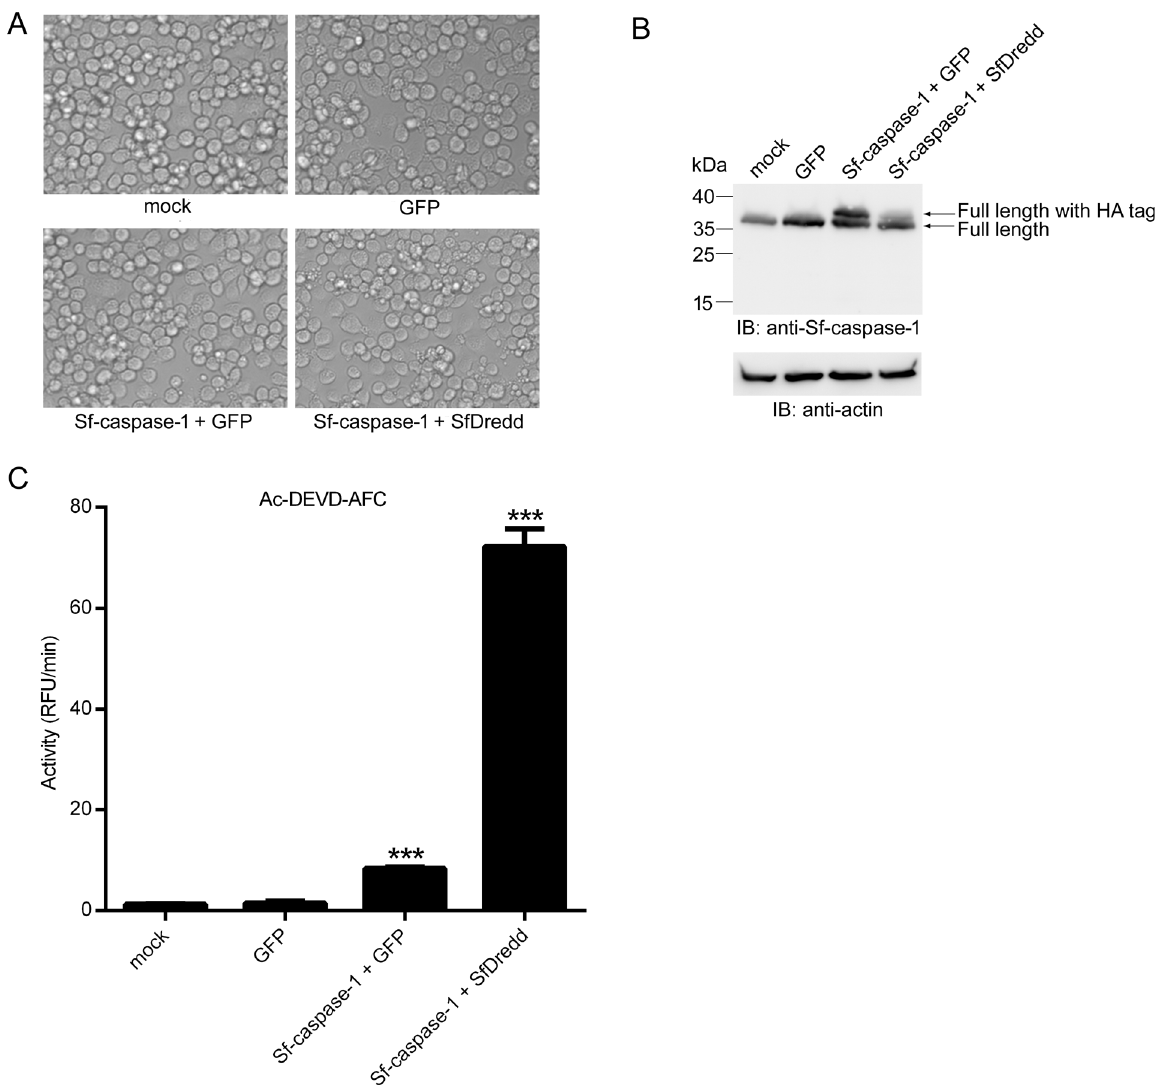
Fig 7. SfDredd cleaved Sf-caspase-1 when transfected in Sf9 cells. Plasmids expressing FLAG-tagged SfDredd and HA-tagged Sf-caspase-1 were co- transfected into Sf9 cells. Mock treated cells, GFP expressed Sf9 cells, and, GFP and Sf-caspase-1 co-expressed Sf9 cells were used as controls. At 42 h post transfection, cells were subjected to the following analyses: (A) Photographs of cells were taken under microscope (magnification ×200). (B) Cell lysates were prepared and analyzed by immunoblotting using antibody against Sf-caspase-1. (C) Cell lysates were incubated with Ac-DEVD-AFC and subjected to caspase activity assay. Caspase activity was indicated as the changes in relative fluorescence units (RFU) per minute. The data were presented with the SD from three independent experiments, and statistical significance was calculated by t test, *** represent significant difference with all the other columns, P <